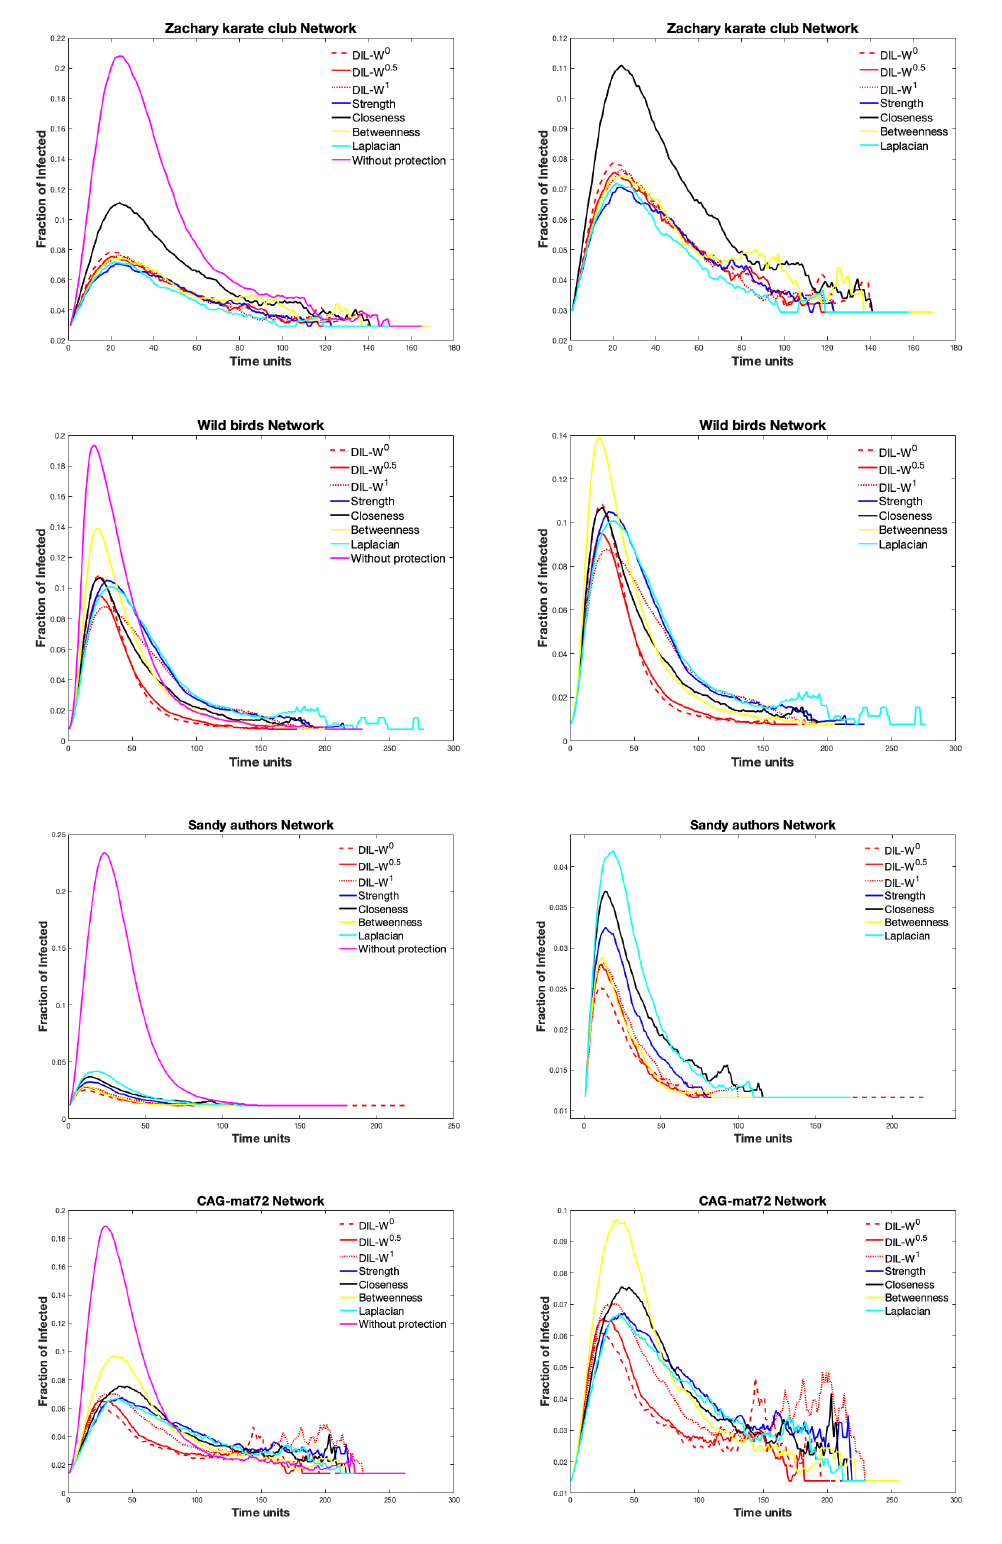
Figure 2. On the right , curve of infected with and without protection on each network. On the left , only curves of infected with protection according to the different